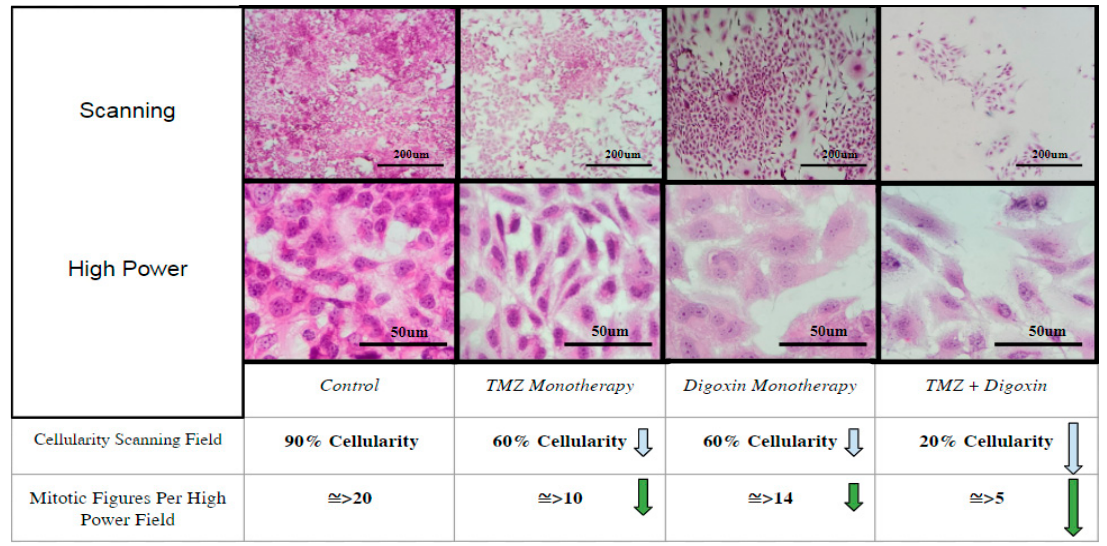
Figure 4. Immunohistochemical Monolayer Viability Analysis. Analysis of colony density and mitotic figures of treated T98G monolayer colonies stained by H&E immunohistochemistry as compared to a non-treated control group taken at 10 × and 40 × magnification respectively. Blue arrows indicate decrease in cell density while green arrows indicate decrease in presence of mitotic figures relative to control group.